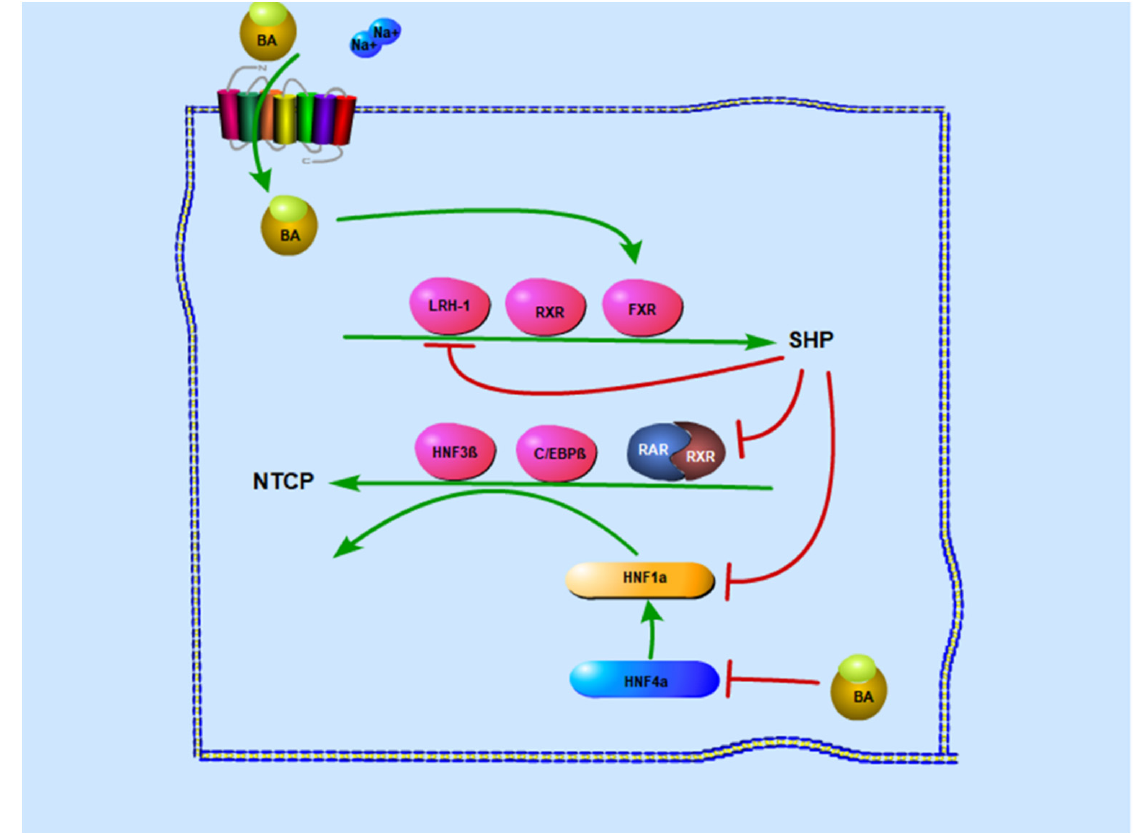
Figure 2. Regulation of NTCP expression levels in vivo. There are mainly two pathways to affect the NTCP expression levels in vivo involving bile acid. On the one hand, bile acids stimulate SHP expression by activating FXR response elements in the SHP promoters, whereas SHP decreases NTCP expression by interfering with RXR: RAR transactivation on the NTCP promoter. At the same time, SHP also inhibits HNF4 α -mediated transactivation of the HNF1 α promoter, to further inhibit NTCP expression. On the other hand, intracellular bile acid also decreases NTCP expression by suppressing HNF1 α via the inhibition of HNF4 α .